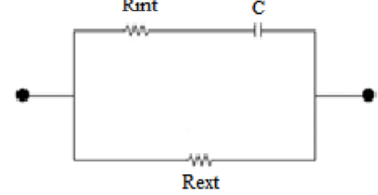
Figure 5: The Debye case of the Cole model circuit (α=1).